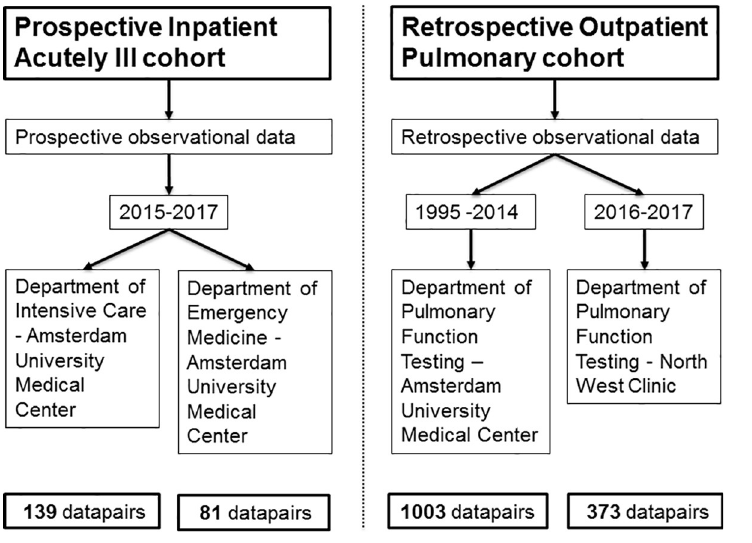
Fig 1. Visual representation of the included